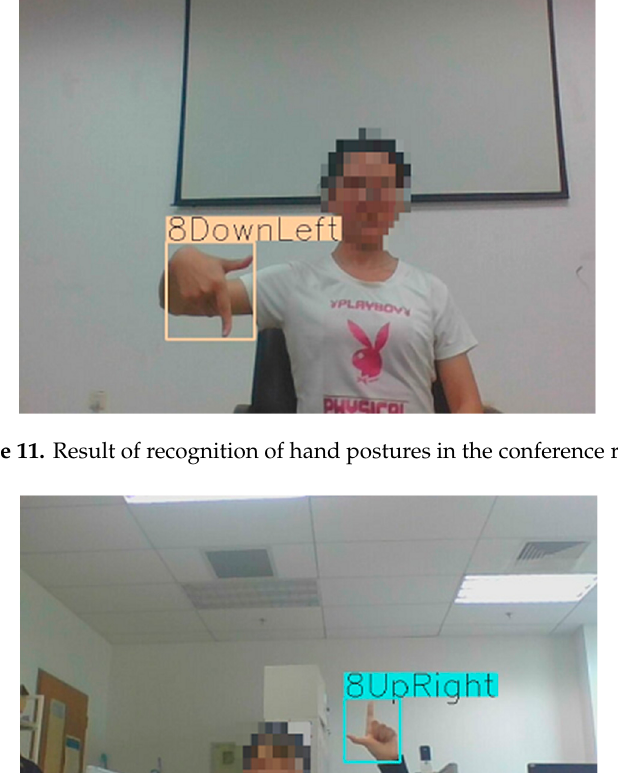
Figure 10. Result of recognition of hand postures in the conference room.